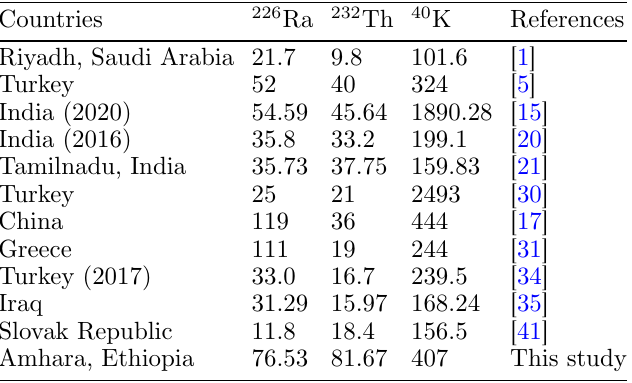
Table 2. Comparison of mean activity concentrations in Bqkg − 1 with studied results in cement samples from some selected